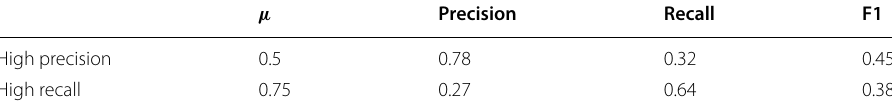
Table 1 The confusion matrix for the network of POLBOOKS with injected edges (Experiment 1)